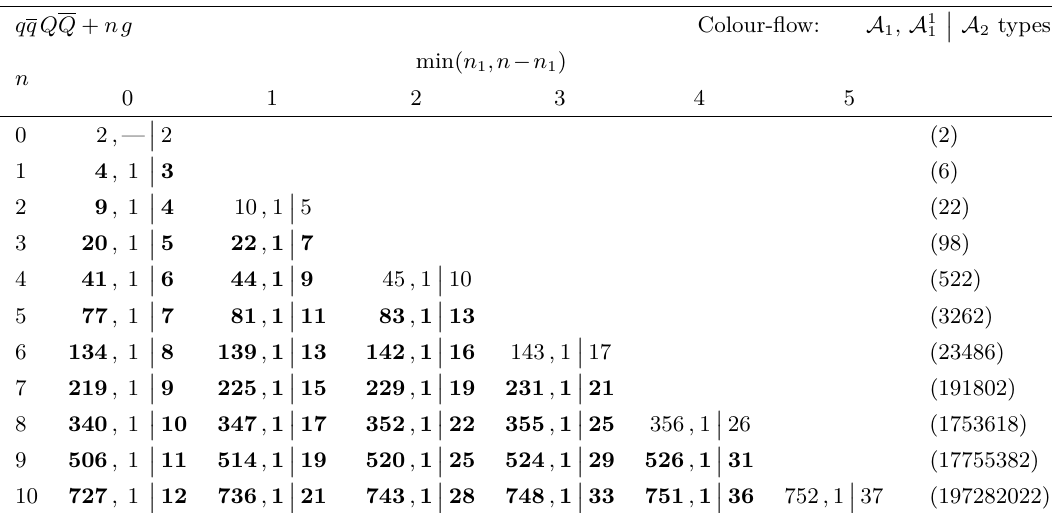
Table 5 . Number of non-zero elements in a single row of the colour matrix for qq QQ + n g (distinct flavours) up to NLC accuracy, N n , in the colour-flow basis. The various columns min( n C correspond to the smallest number of gluons of the two partitions n eq. (3.12). Within a column, the numbers correspond to dual amplitudes of types A the vertical bars, A , see eqs. (3.12) and (3.14). The numbers between brackets in the final column 2 denote the total number of columns in the colour matrix. In bold are marked those numbers which appear twice in the mirrored